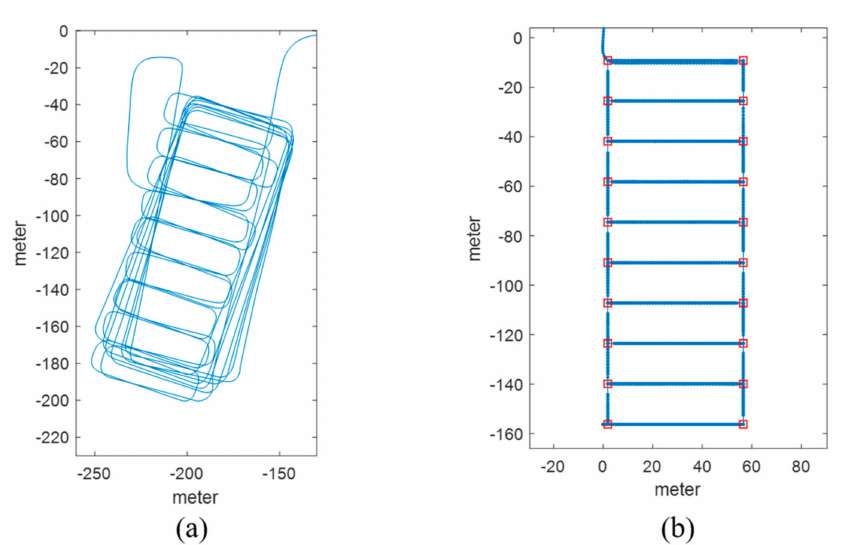
Figure 5. Vehicle trajectory by dead reckoning using OBD2 and smartphone. ( a ) Before map matching; ( b ) After map matching.